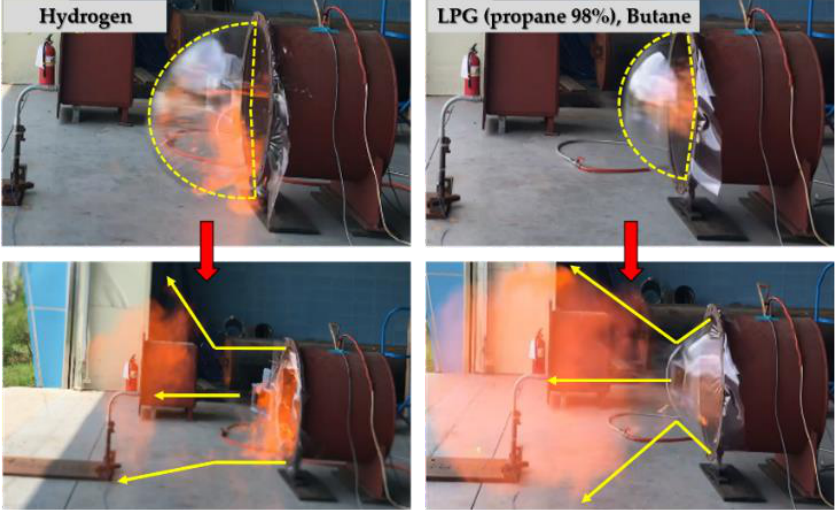
Figure 12. Explosive shape of plastic sheet (hydrocarbon versus hydrogen).